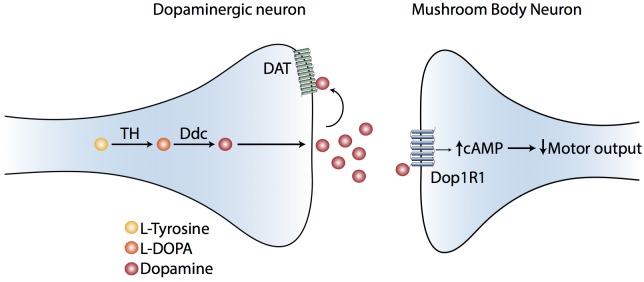
A model to explain the contribution of Dop1R1 expressed in MB to Drosophila larval locomotion.This model proposes, that the type 1 Dop1R1 receptor is expressed in MB and activated by dopaminergic neurons arriving to this brain area. The activation of the dopamine receptor induces an increase in intracellular cAMP levels, which results in decreased motor output. DAT, the dopamine plasma membrane transporter, regulates the availability of dopamine in the synaptic cleft, so that when it is not present or not functional, increases dopaminergic signaling, which results in reduced motor output.